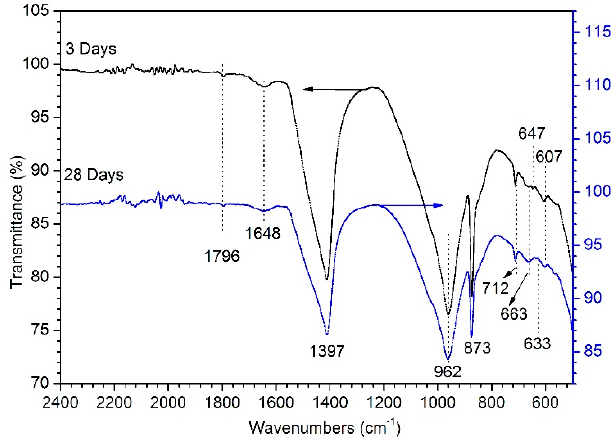
Figure 8. FT-IR spectra of leaded solidified samples at different hydration ages.